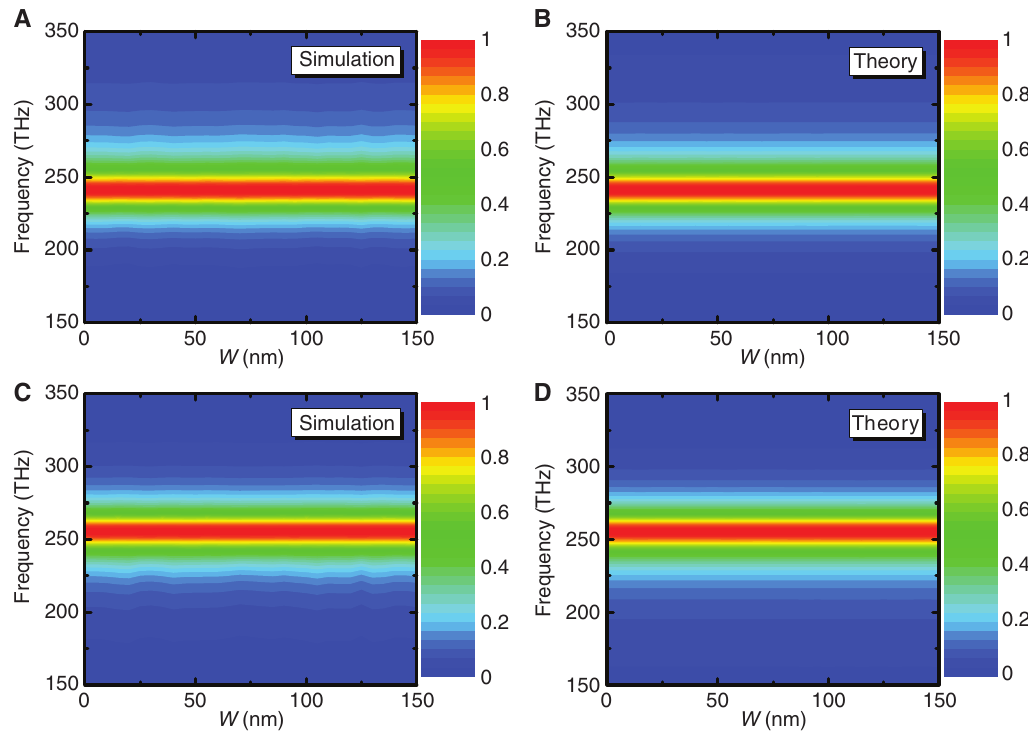
Figure 6: The spectrum of PC-SCPA of the designed optical system possessing the phase coupling as a function of the lateral spacing distance w for antisymmetric and symmetric incidences, respectively. (A) and (C) are simulation results for antisymmetric and symmetric incidences, respectively. (B) and (D) are theoretical results for antisymmetric and symmetric incidences,